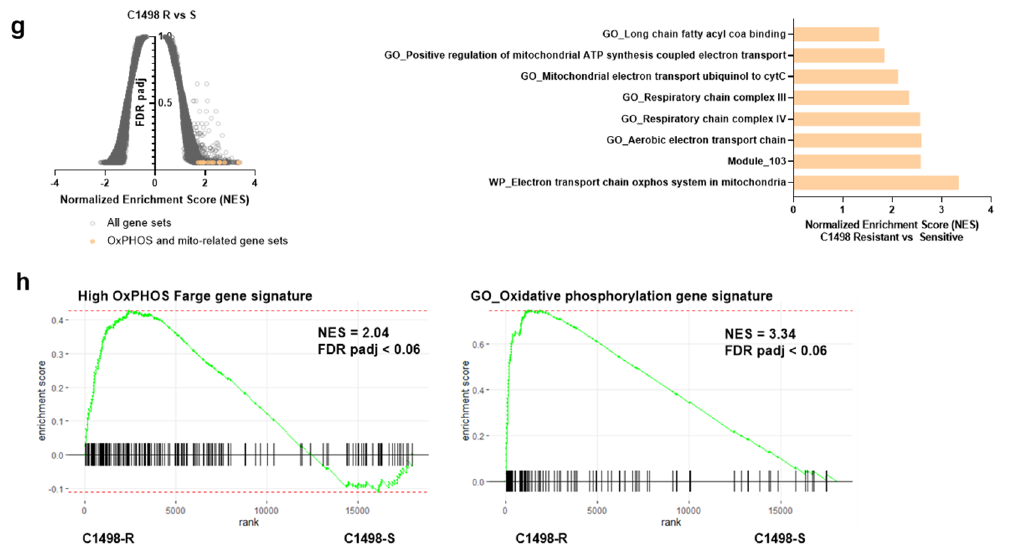
Figure 2. AraC-tolerant leukemic cells have more active mitochondria. ( a ) Proliferation IncuCyte assay of murine leukemic C1498 and L1210 cell lines sensitive (C1498S, L1210S) and resistant (C1498R, L1210R) to AraC. ( b ) Seahorse assessment of basal and maximal respiration in murine leukemic cells sensitive or tolerant to AraC ( n = 4). ( c ) FACs assessment of mitochondrial membrane potential with the TMRE probe in AraC-sensitive vs. -resistant conditions for both cell lines ( n = 4); ( d ) Mitochondrial mass assessment with MTDR (MitoTracker Deep Red) in both cell lines in the condition of sensitiveness and resistance to AraC ( n = 4). ( e ) Total and mitochondrial ATP content measured by Cell Titer Glo in C1498 and L1210 cell lines sensitive and resistant ( n = 4). ( f ) Protein expression levels assessed by Western blot of the ETC complexes in C1498 sensitive and resistant to AraC ( n = 3). ( g ) Volcano plot showing the signatures enriched in AraC-resistant vs. -sensitive C1498 cells (FDR q-val < 0.05) on the left and a plot showing OxPHOS and mitochondrial-related gene sets differentially expressed in resistant vs. sensitive conditions with their normalized enrichment scores (NES). ( h ) Gene set enrichment plot of the GO oxidative phosphorylation and Farge_High OxPHOS gene signatures in resistant vs. sensitive C1498 cells. * is p < 0.05, ** is p < 0.01, *** is p < 0.005, ns is statistically